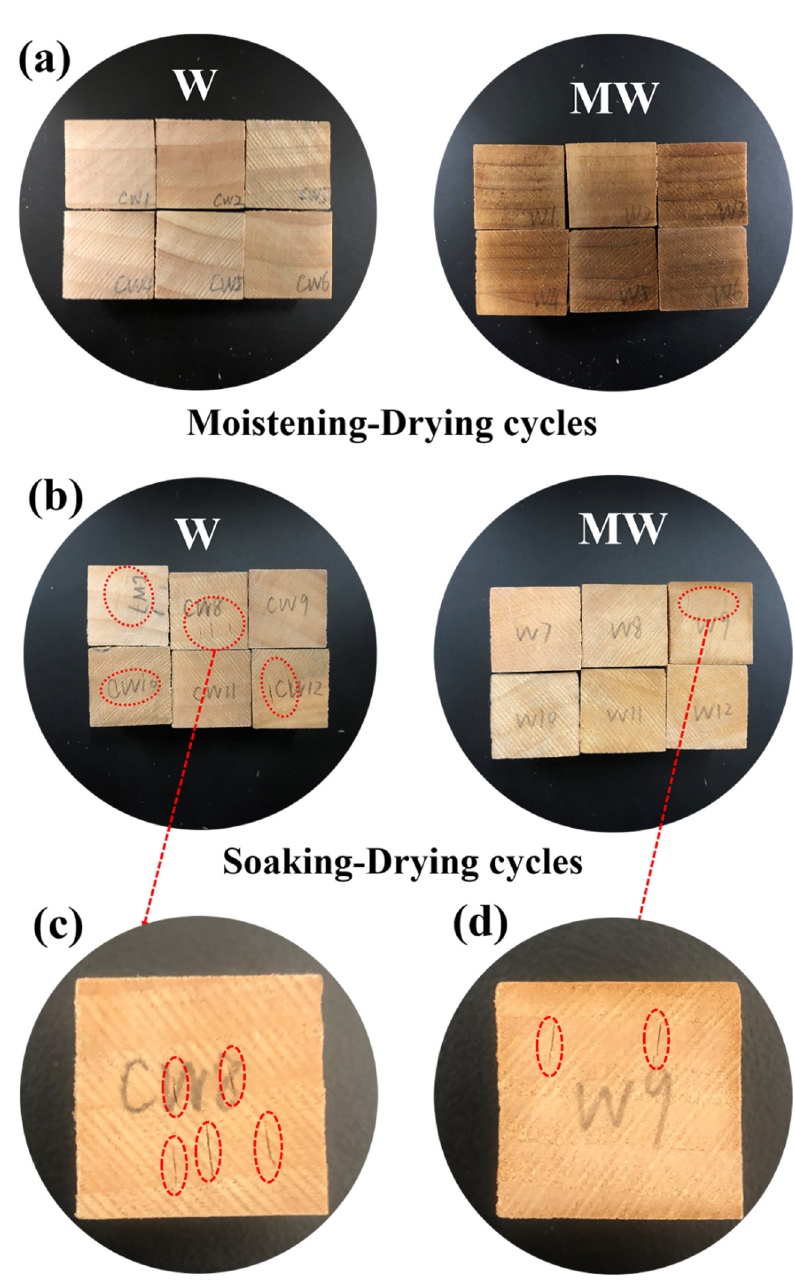
Figure 6. Digital photos of W and MW after moistening-drying cycles ( a ) and after soaking-drying cycles ( b ); ( c , d ) show higher magnifications for the cracked samples. The cracks are indicated by red circles.